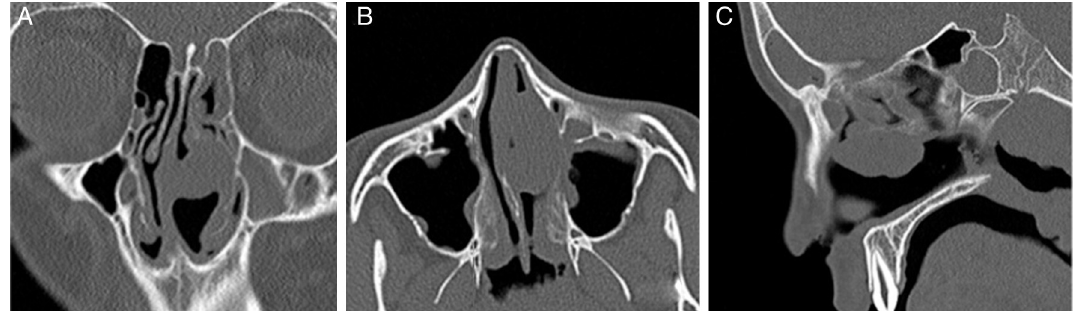
Figure 2 Intensely enhanced homogenous mass lesion originating from the left middle turbinate on coronal (A), axial (B), and sagittal (C) computed tomography